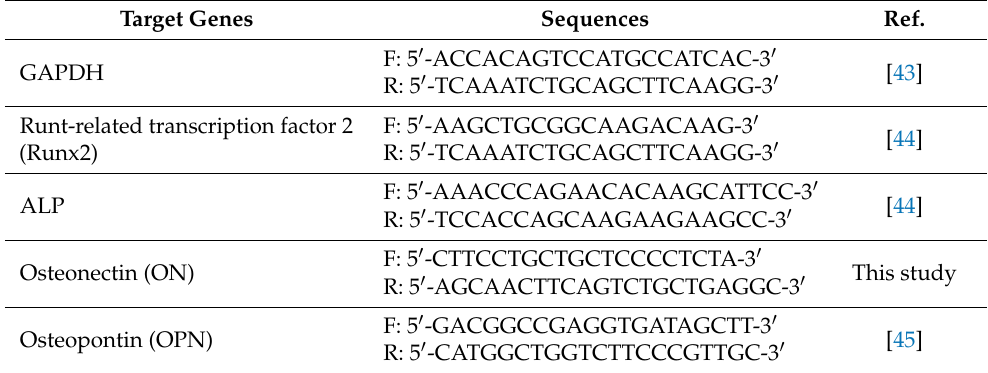
Table 1. Primer sequences used for the real-time polymerase chain reaction (PCR) analysis. Target Genes Sequences